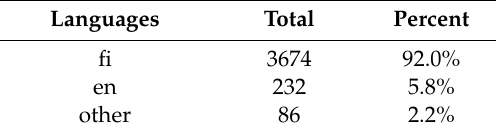
Table A18. English language availability (fi).